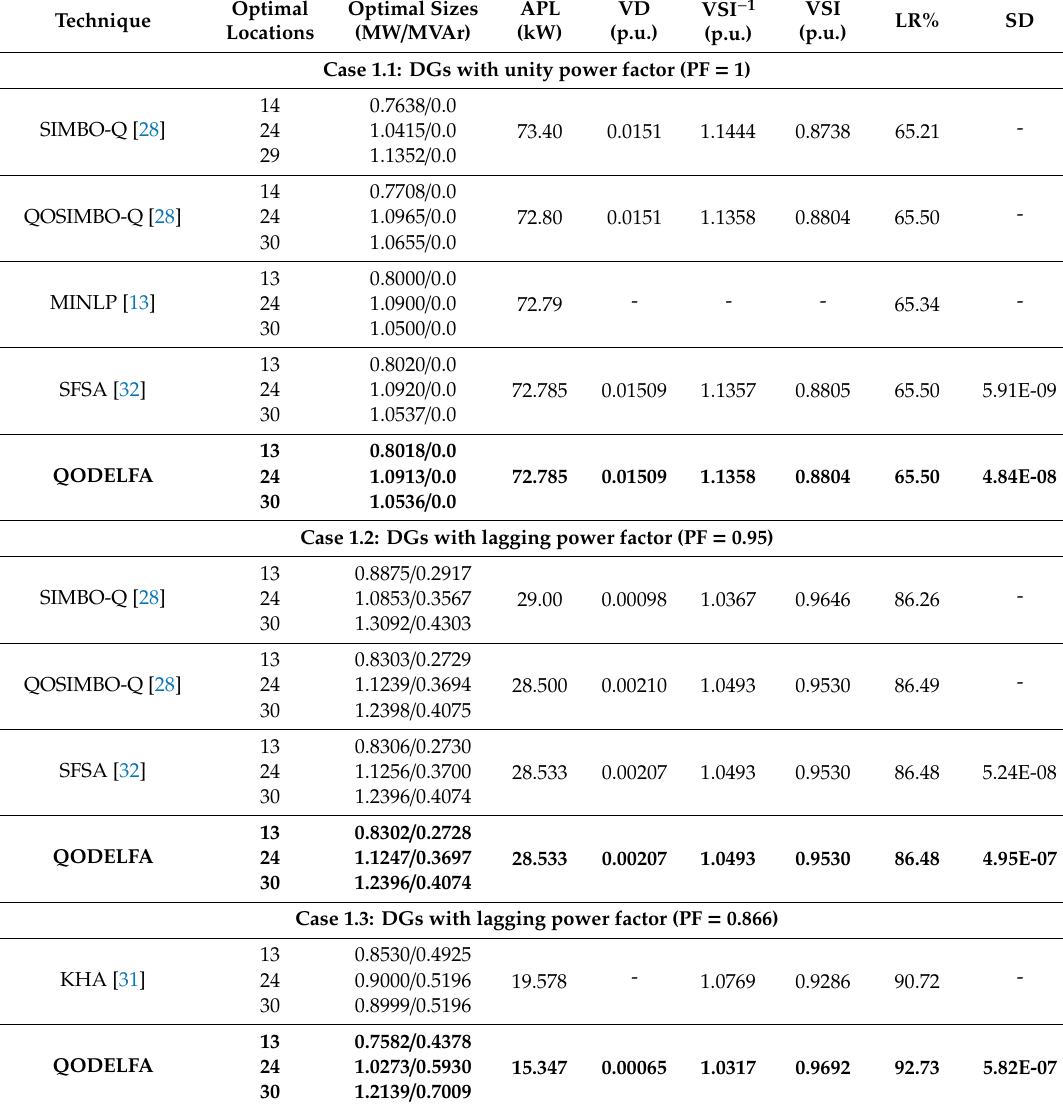
Table 3. Results for the IEEE 33-bus RDS with active power loss (APL) minimization (objective function 1, (OF 1